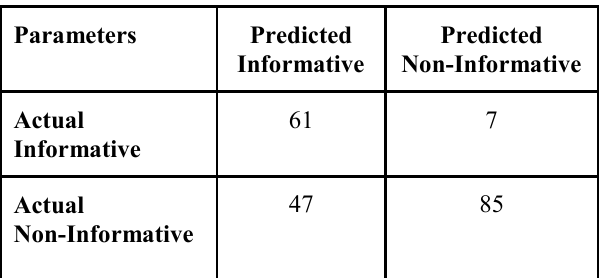
Table 2. Confusion